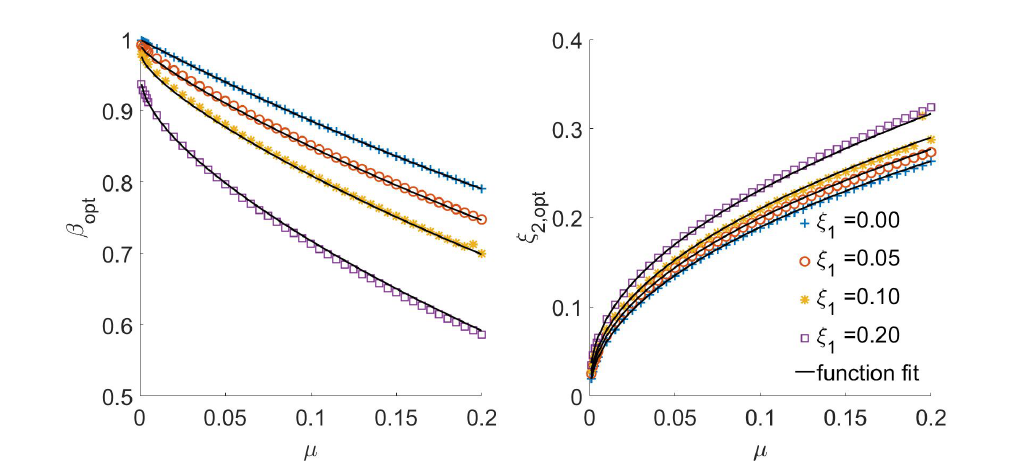
Figure 7. Optimum TMD parameters: TF No. 5.